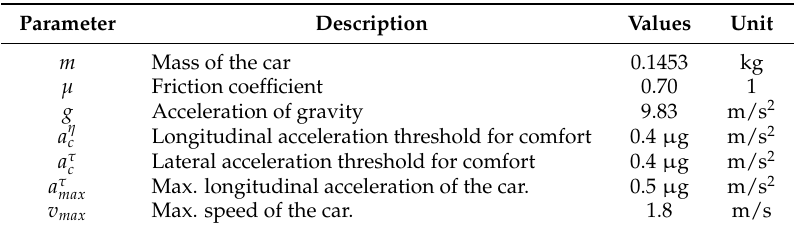
Table 3. Parameter